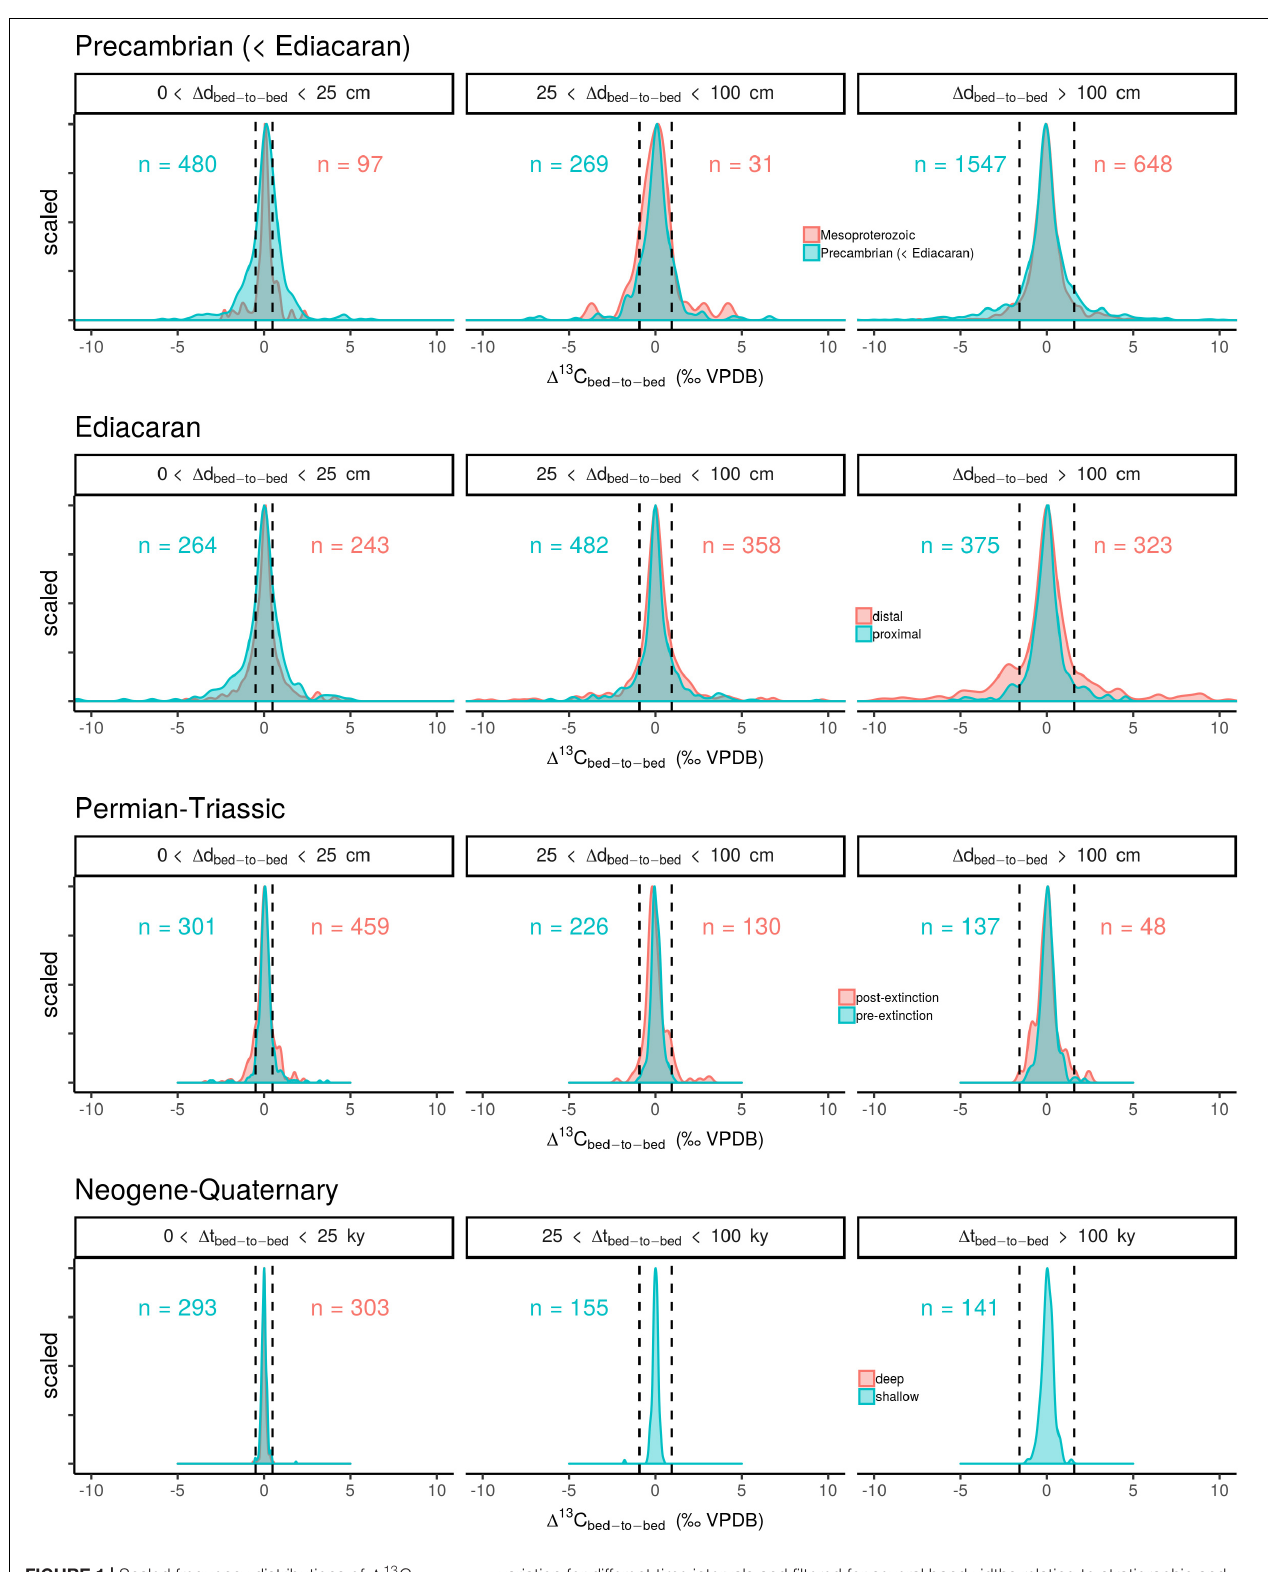
Frontiers in Earth Science |